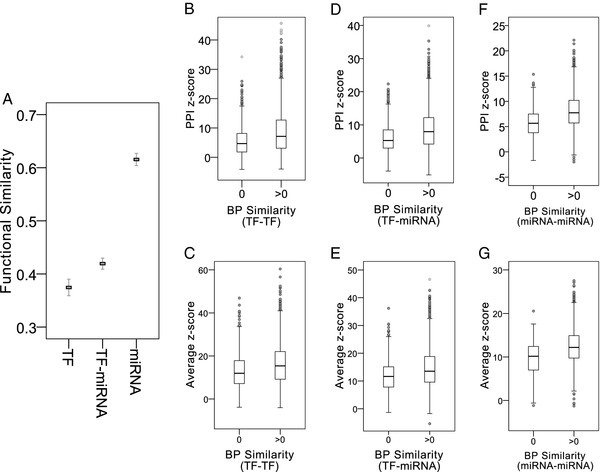
Functional features of the crosstalk motifs. (A) The functional similarity between two regulators in the crosstalk motifs. The rectangular markers indicate the average values and error bars indicate the 95% confidence intervals. (B)--(G) Comparison of PPI z-score and average network property z-score between the crosstalk motifs with zero and non-zero functional similarity. Average z-score represented the averaged network property z-score.